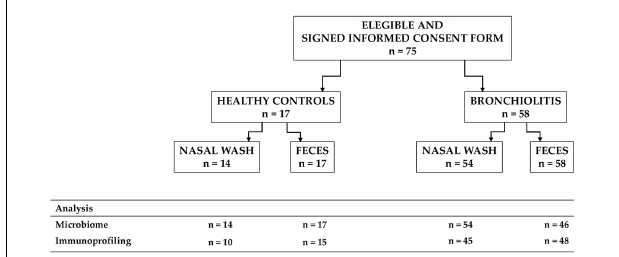
Values are number (percentage) of participants, except mean (95% confidence interval) for weight. *Fisher exact tests were used to evaluate differences in frequencies of the analyzed parameters except Chi-squared tests for gender and age (unknowns were not taken into consideration) and Wilcoxon rank sum test to evaluate differences in weight (percentile). Bold font indicates values having differences that are statistically